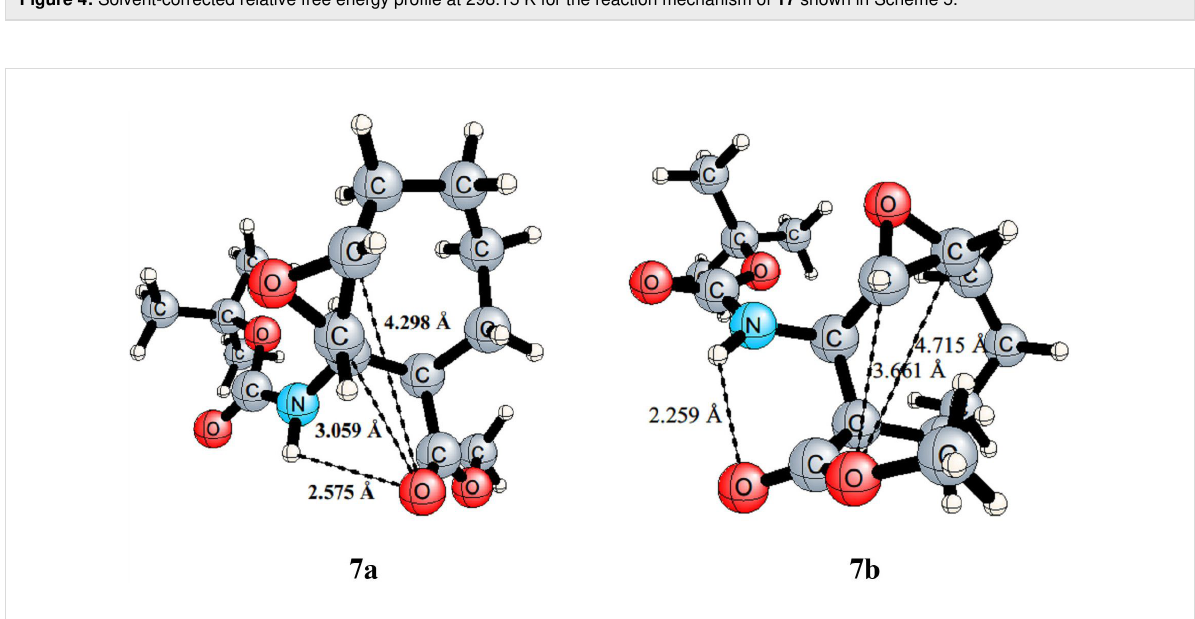
Figure 5: The optimized geometries of the conformers 7a and 7b with selected interatomic distances at the B3LYP/6-311++G(d,p) level.